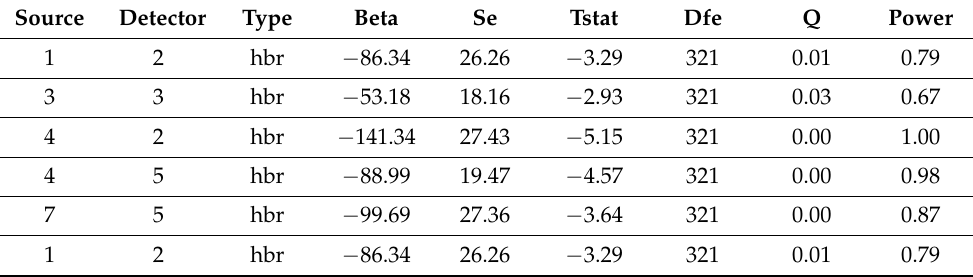
Table A8. t -test statistics for each channel (source–detector pair). Mountain Pose Start–Extended Hand to Right Big Toe Hold.